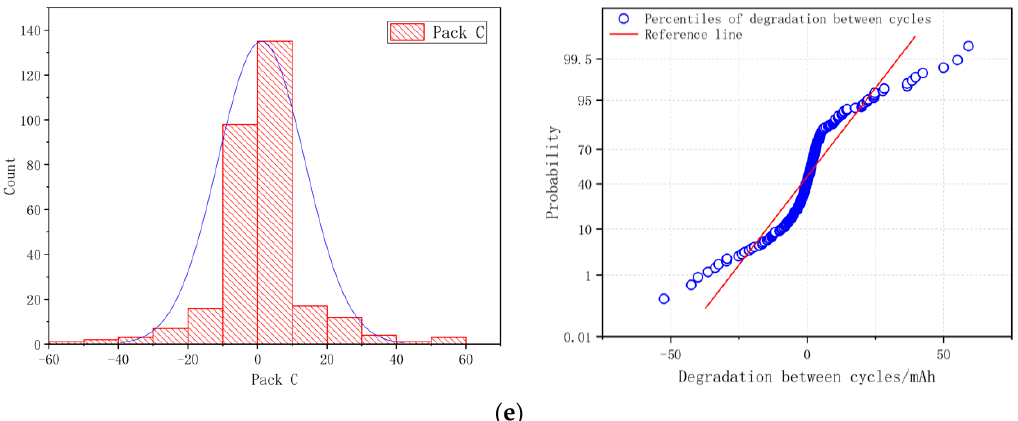
Figure A2. Probability map of capacity degradations between cycles: ( a ) Cell-5; ( b ) Cell-6; ( c ) Cell-7; ( d ) Cell-8; ( e ) Pack C.